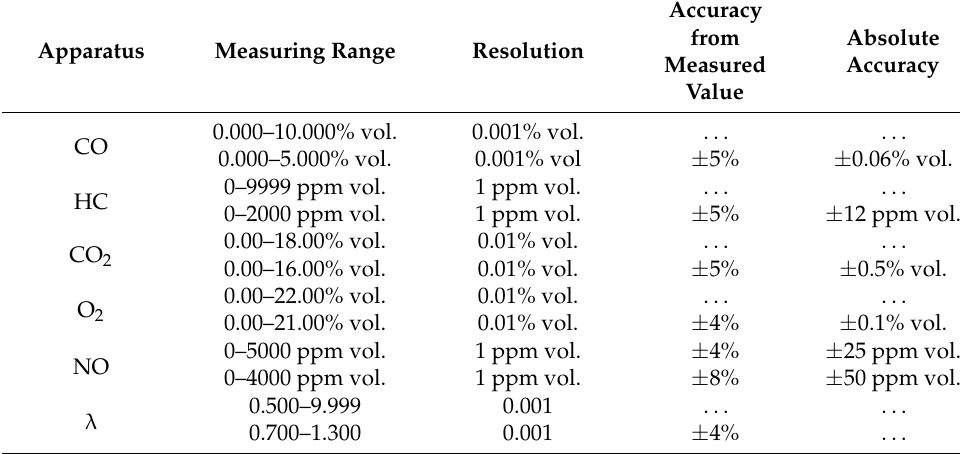
Table 2. Parameters of the Bosch BEA 350